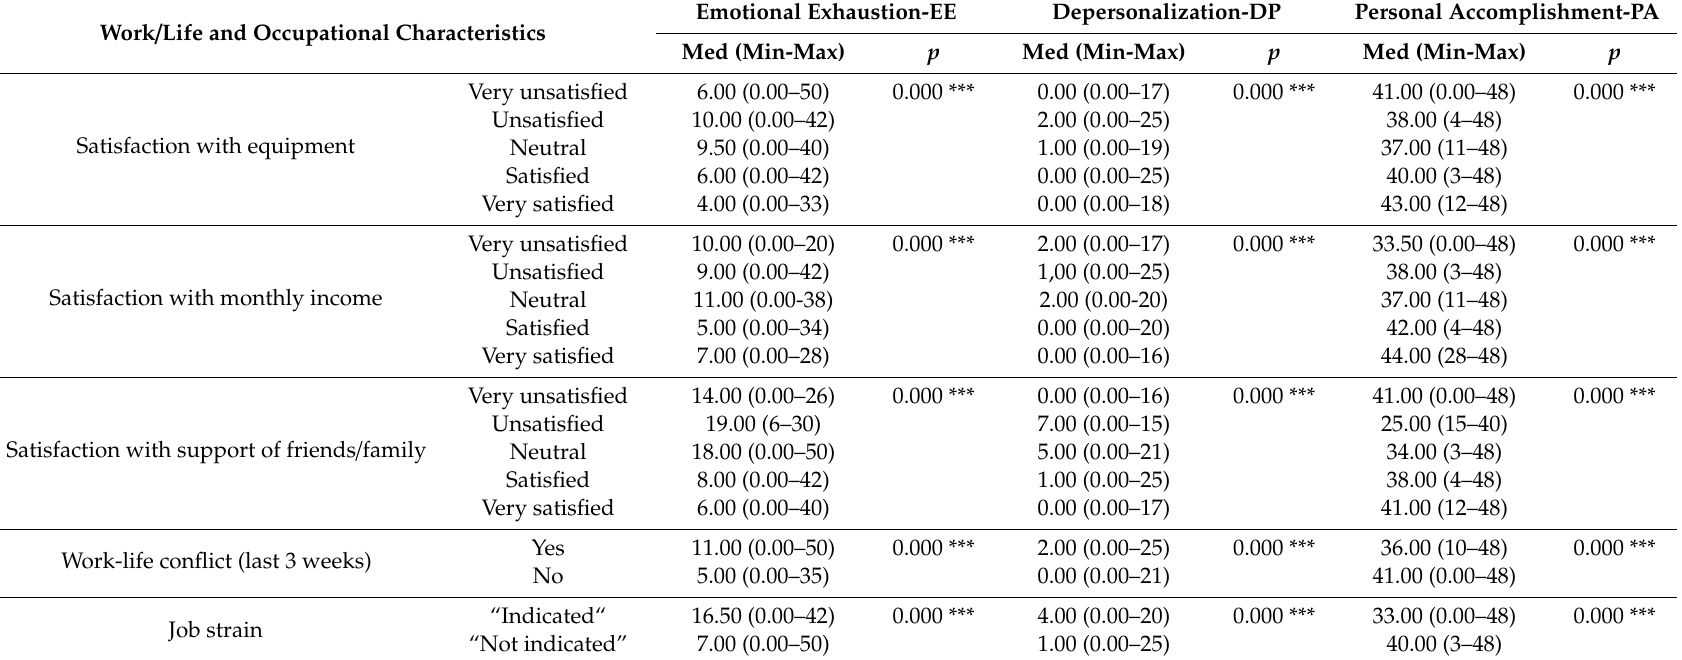
Table 5. Burnout scores stratified by work / life and occupational